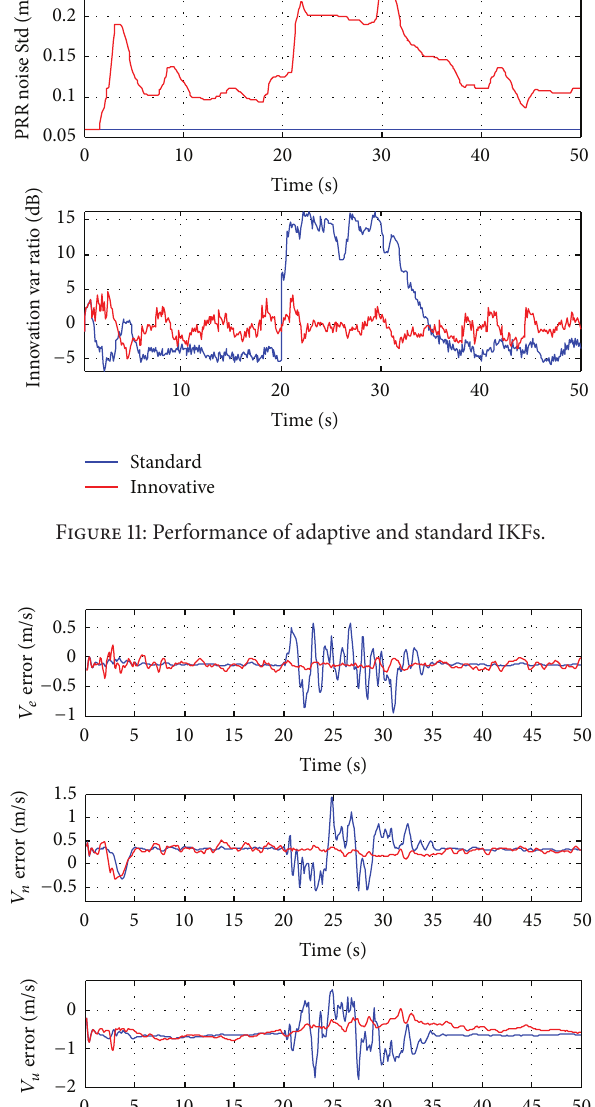
Figure 10: PRR error comparison in jamming.